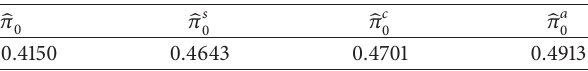
Figure 1: Histogram of the 𝑝 values for leukemia data reported in Golub et al. [5]. Table3:Theestimatesoftheproportionoftruenullhypotheseswith the microarray data of Golub et al.